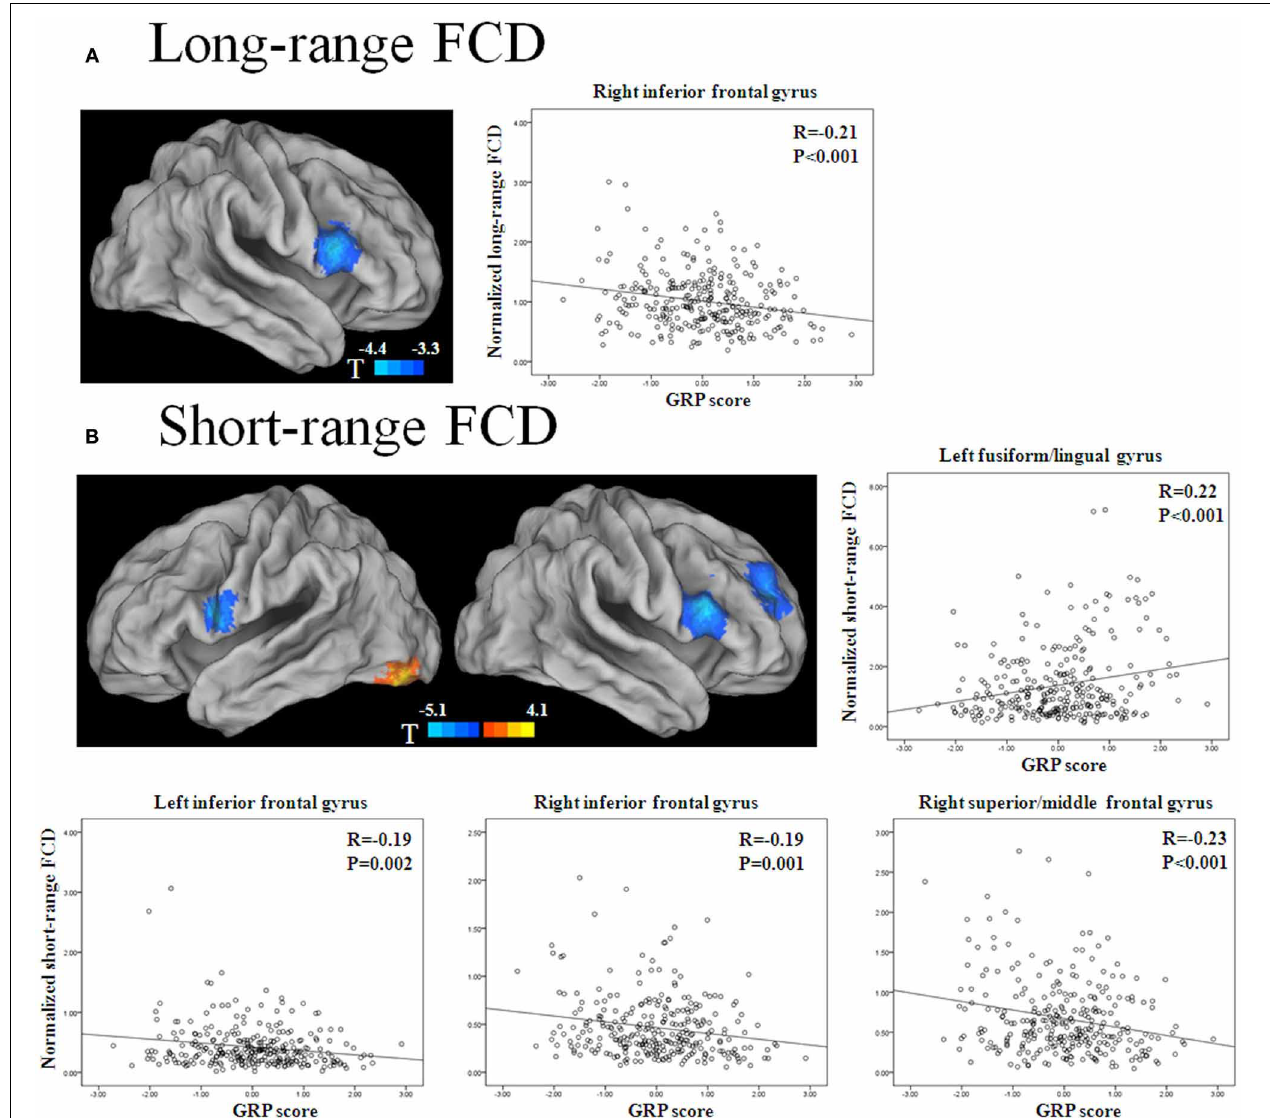
FIGURE 1 | Statistical significance ( T -score) of the correlation with the GRP score for long-range FCD (A) and short-range FCD (B) across 289 healthy participants, overlaid on the surface of the Colin template. The cool color represents a negative correlation, and the warm color represents a positive correlation. The images were created using the Computerized